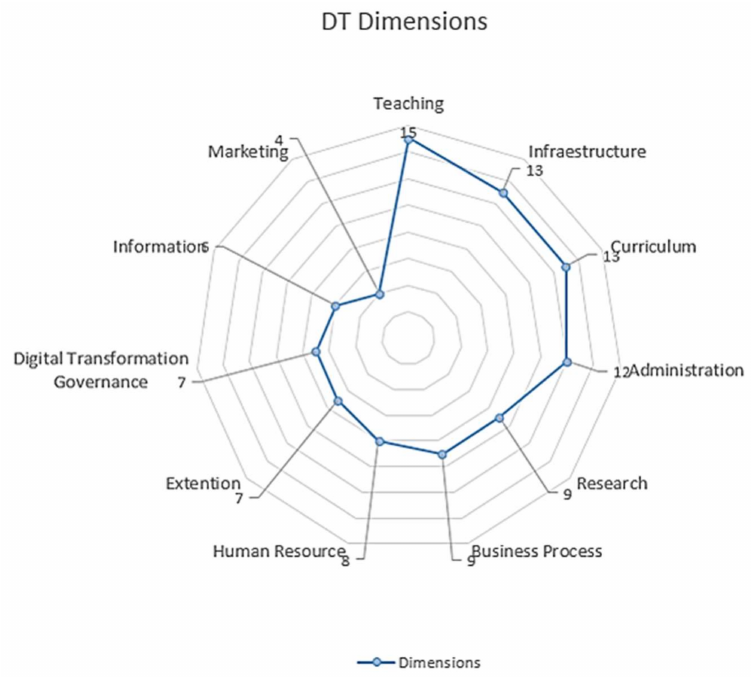
Figure 4. Radar of the dimensions of the DT in